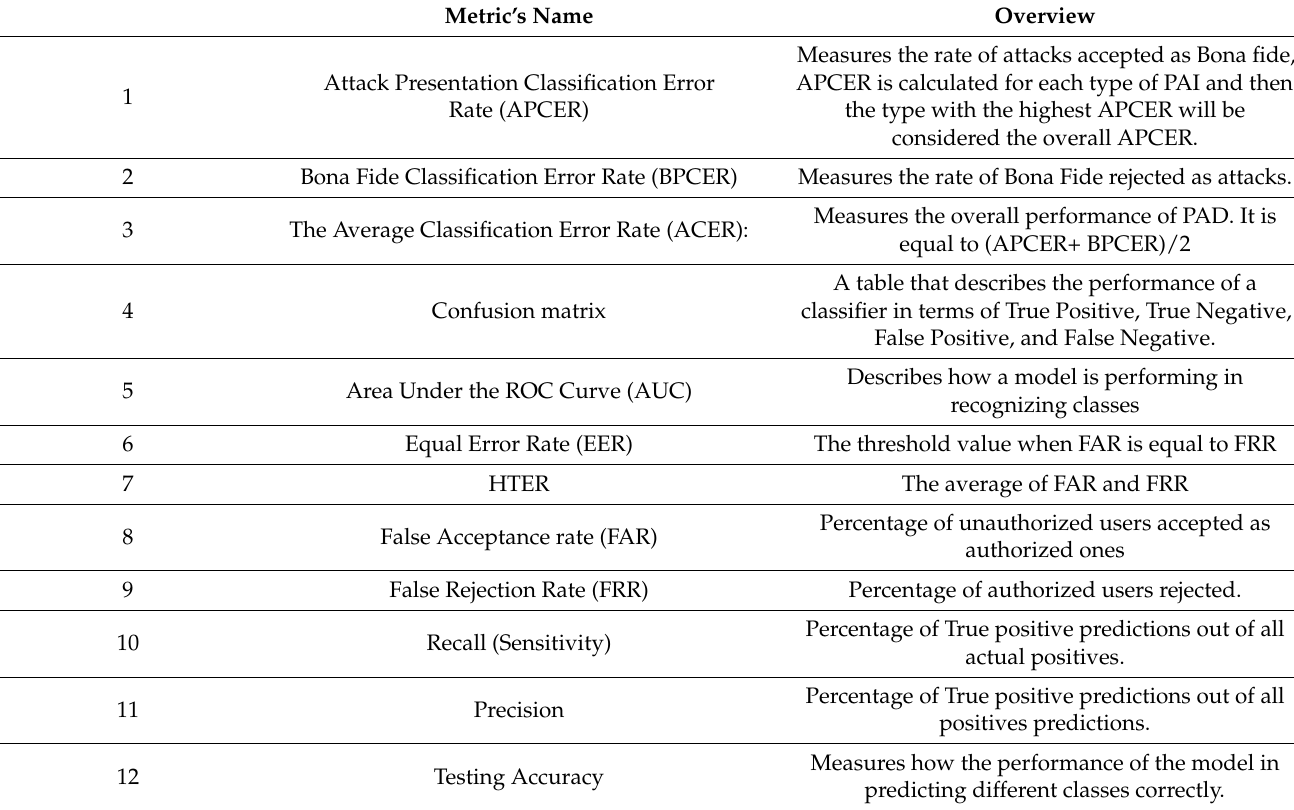
Table 1. Evaluation metrics